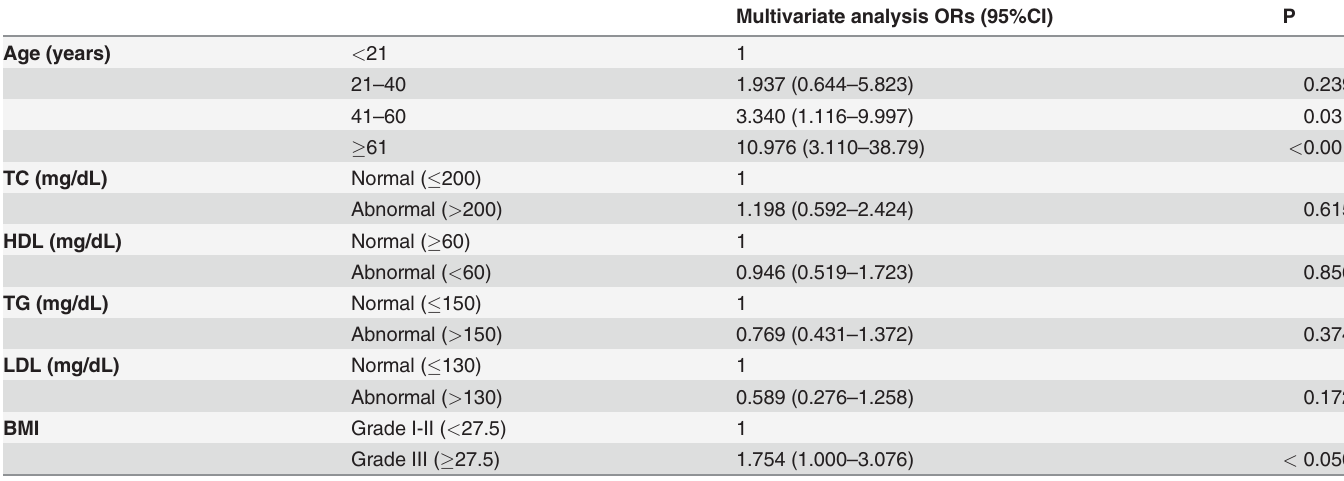
Table 4. Multivariable logistic regression analysis for outcome (treatment failure) among patients with sudden sensorineural hearing